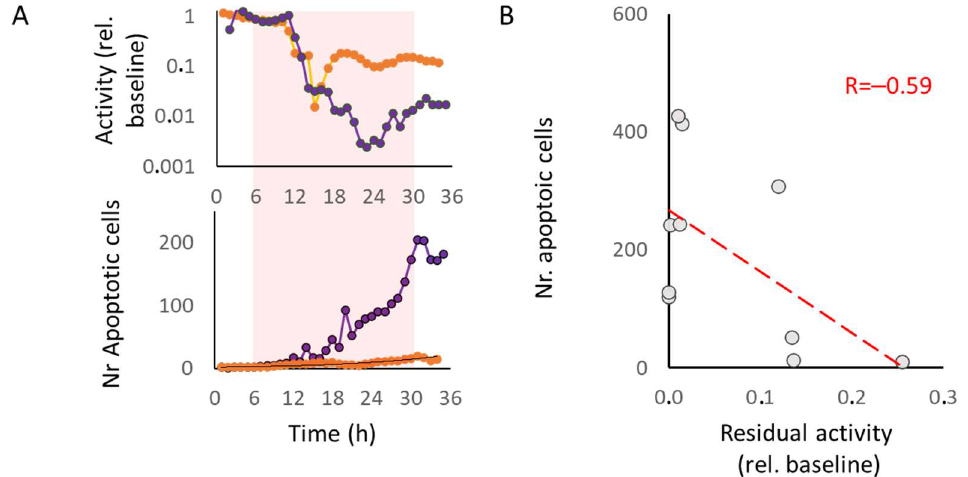
Figure 4. Temporal evolution of apoptosis and residual activity in cultures exposed to 24 h of hypoxia. Activity decreased in all cultures during hypoxia, but residual activity varied between cultures. ( A ) Examples of cultures with relatively high (orange) and relatively low (purple) residual activity (top panel) during hypoxia (10% of normoxia, light-red area). Fewer cells became apoptotic (bottom panel) in the culture with more residual activity than in the culture with less activity. ( B ) When all cultures were grouped, the average amount of remaining activity during the second half of the hypoxic phase ( t = 18–30 h) negatively correlated with the number of apoptotic cells at t = 35 h. Red dashed line indicates fitted linear trend line (R = −0.59, p = 0.07).